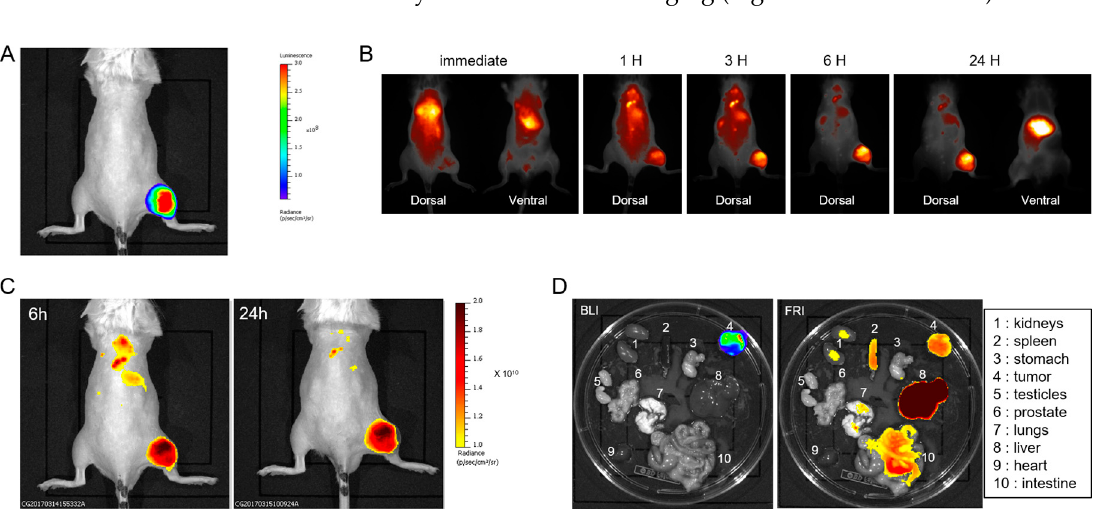
Figure 1. In vivo detection of LipImage TM 815 accumulation in subcutaneous tumors. ( A ) Bioluminescence image (BLI) of a representative mouse; ( B ) Fluorescence reflectance imaging (FRI) of a representative mouse at different time after LipImage TM 815 injection; ( C ) FRI of a representative mouse 6 h and 24 h after LipImage TM 815 injection, respectively; ( D ) Ex vivo BLI and FRI of mouse organs 24 h after LipImage TM 815 injection.